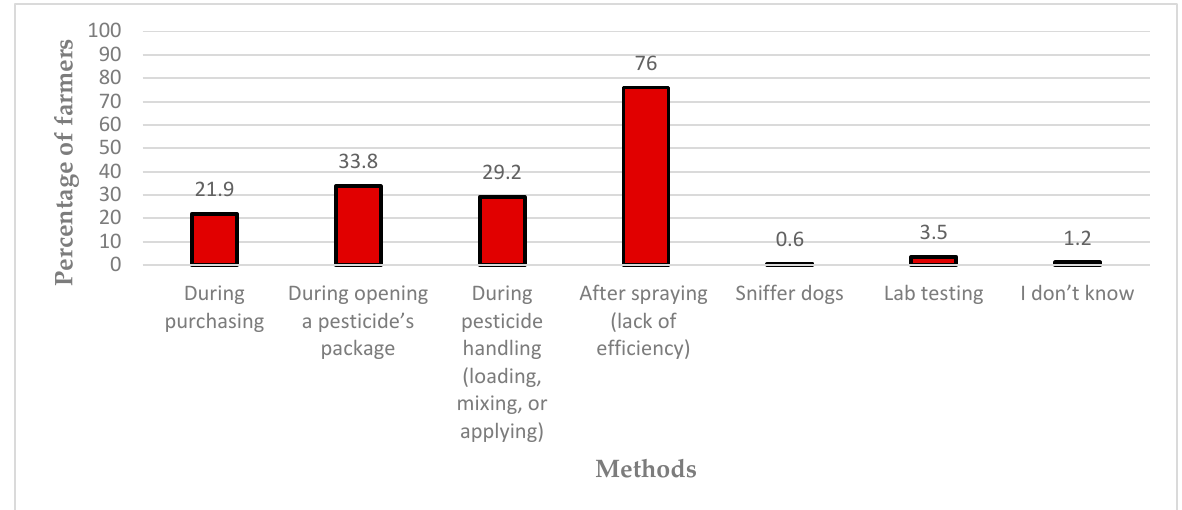
Figure 1. Timeliness and method of identifying fraudulent pesticides (by the farmers who purchased fraudulent pesticides).